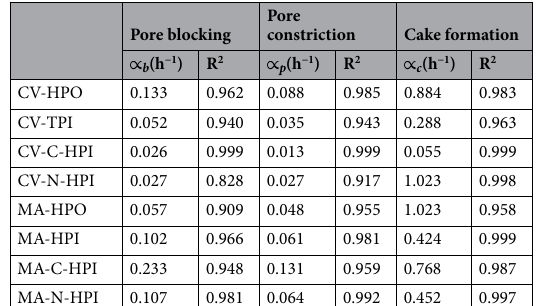
Pore constriction Cake formation